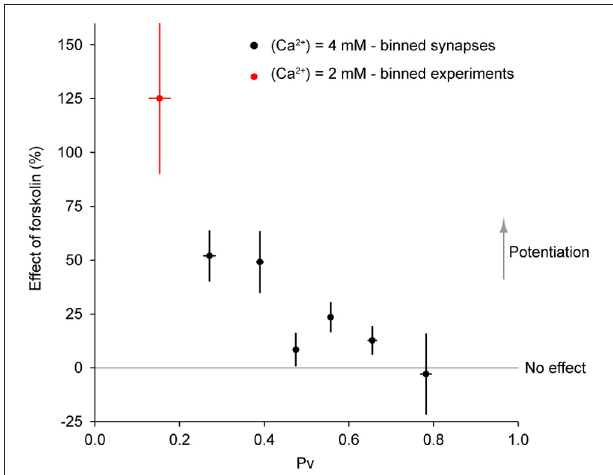
FIGURE 9 | The effect of forskolin on exocytosis in response to a single action potential is negatively correlated with Pv . Combined data with 4mM extracellular Ca 2 + ( Figure 8B1 , binned across synapses) and 2mM extracellular Ca 2 + (see text, binned across experiments) shows an inverse relationship between initial Pv and the effect of forskolin ( ρ = − 0 . 88, P = 0 .